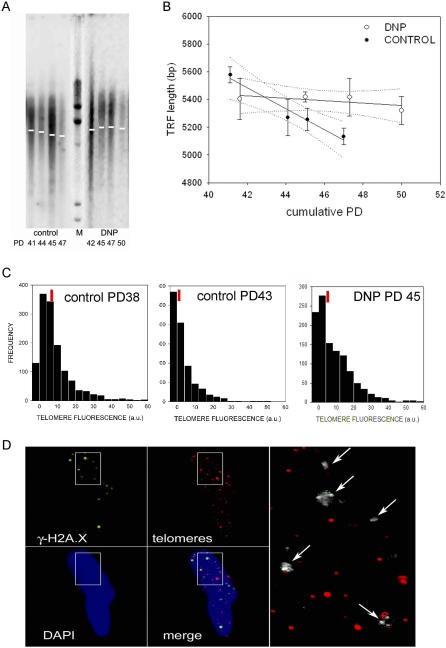
Delayed Senescence in DNP-Treated Fibroblasts Is Telomere Dependent(A) Telomere in-gel hybridisation of untreated (control) and DNP-treated MRC5. The size-weighted average of each peak is indicated by a white line. A λHindIII DNA digest is used as size marker (M).(B) Average telomere (TRF) length in controls and DNP-treated MRC5 fibroblasts. Data are mean ± s.e.m. from quadruplicate gels. Solid line: linear regression, dotted lines: 95% confidence intervals. Differences between slopes are significant (2-tailed t test, p = 0.002).(C) Telomere Q-FISH histograms of untreated (control) and DNP-treated MRC5 at the indicated PD. Medians are indicated by red bars and are at 6.0 arbitrary units (a.u.) (control PD 38), 1.3 a.u. (control PD 43), and 5.7 a.u. (DNP PD 45). Histograms of control PD 43 and DNP PD 45 are significantly different from each other according to a Mann-Whitney test (p-value < 2.2 × 10−16).(D) ImmunoFISH of senescent DNP-treated cells at PD 50. γ-H2A.X–containing foci are shown in green and telomeres in red. The boxed area is shown as deconvoluted image at higher magnification at the right. Pixels that show significant co-localisation between foci and telomeres according to a Pearson correlation analysis are shown in white (indicated by arrows).